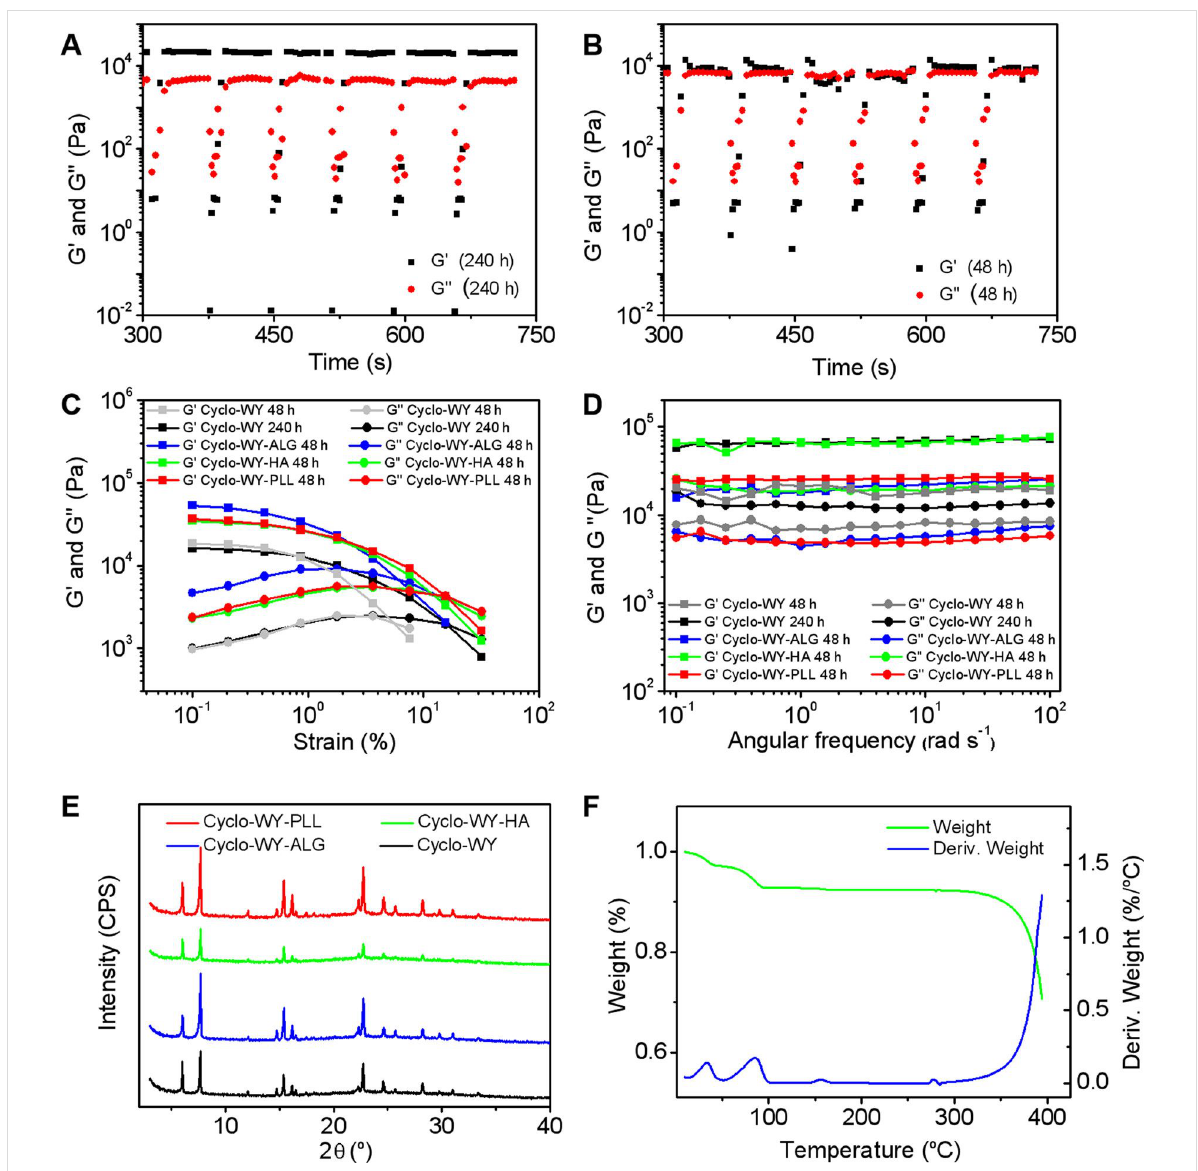
Figure 3: Rheological characterization and environmental tolerance. The self-healing capacity of the hydrogels at 48 h (A) and 240 h (B) demon- strated by the continuous step–strain experiments. Strain-dependent (C) and frequency-dependent (D) oscillatory shear rheology of the hydrogels under various conditions. (E) XRD patterns of hydrogels with various polymers. (F) TG curves of the C-WY hydrogel.